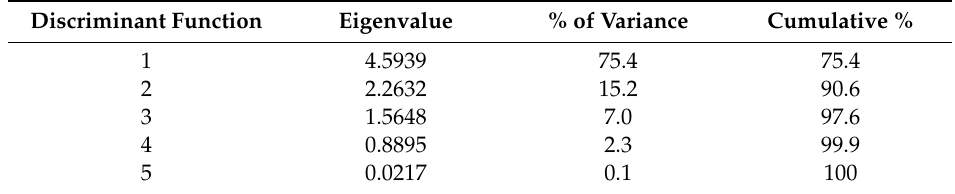
Table 4. Performance of Linear Discriminant Analysis (LDA) on well log data of the southern basin of the South Yellow Sea.